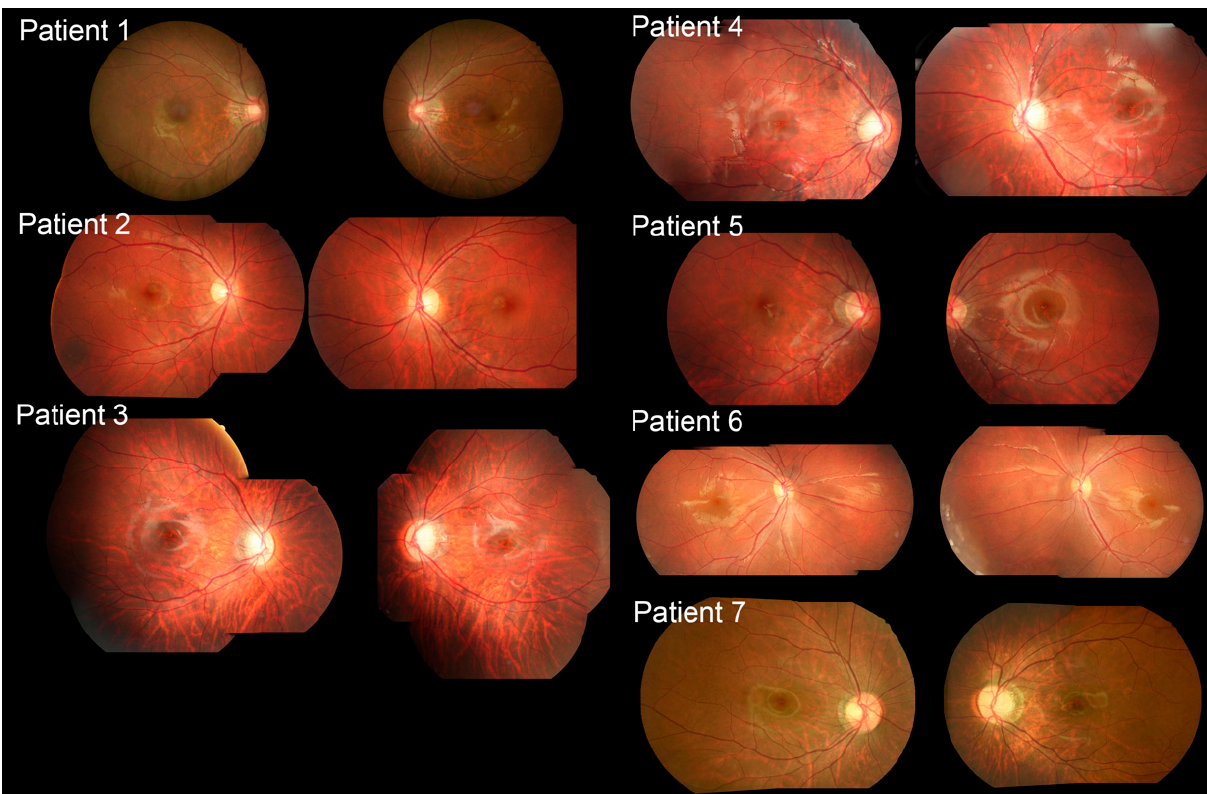
Figure 1. Color fundus imaging. Patient 1 presented with normal fundus photography without any bone spicules, arteriolar attenuation, or disc pallor. Color fundus imaging showed peripapillary atrophy and a temporal crescent in both eyes. Patient 2 had normal color fundus photography except a nevus in the right periphery. Patient 3 ′ s color fundus photography showed tessellated fundus and a large optic nerve in both eyes with slightly enlarged cupping in the left eye. Patients 4–7 presented with normal fundus photography.